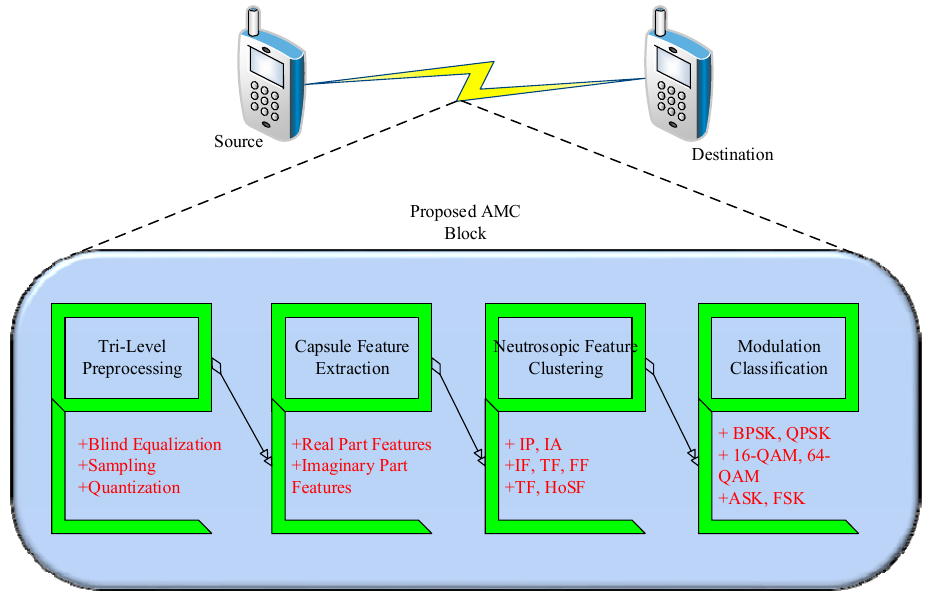
Figure 7. Pipeline architecture of proposed automatic modulation classification (AMC).